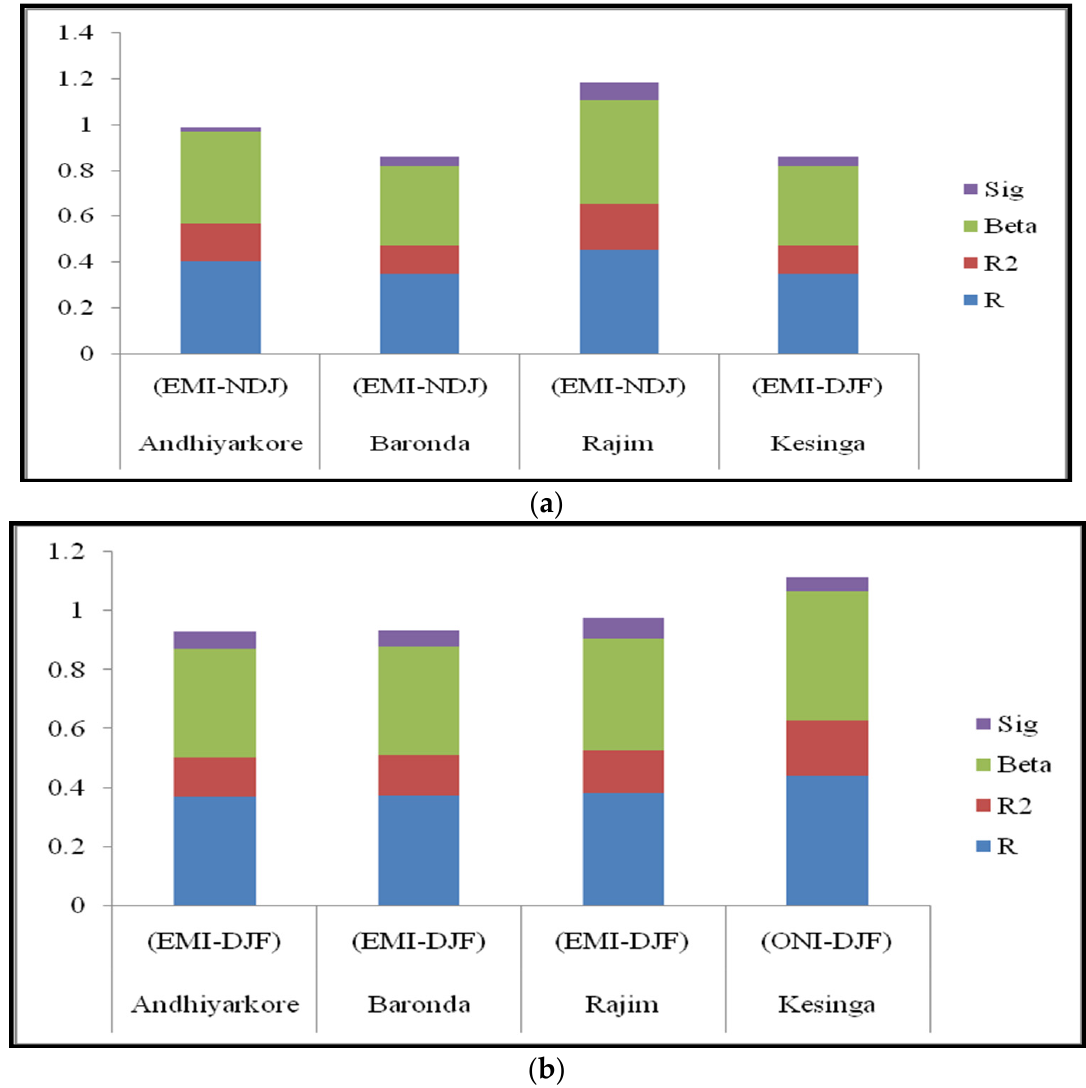
Figure 6. ( a ) Stepwise regression analysis for JJA season considering EMI, ONI, and Nino3 indices of the November–January (NDJ) and December–February (DJF) seasons as the independent variables; ( b ) Stepwise regression analysis for SON season considering EMI, ONI, and Nino3 indices of NDJ and DJF season as the independent variables.